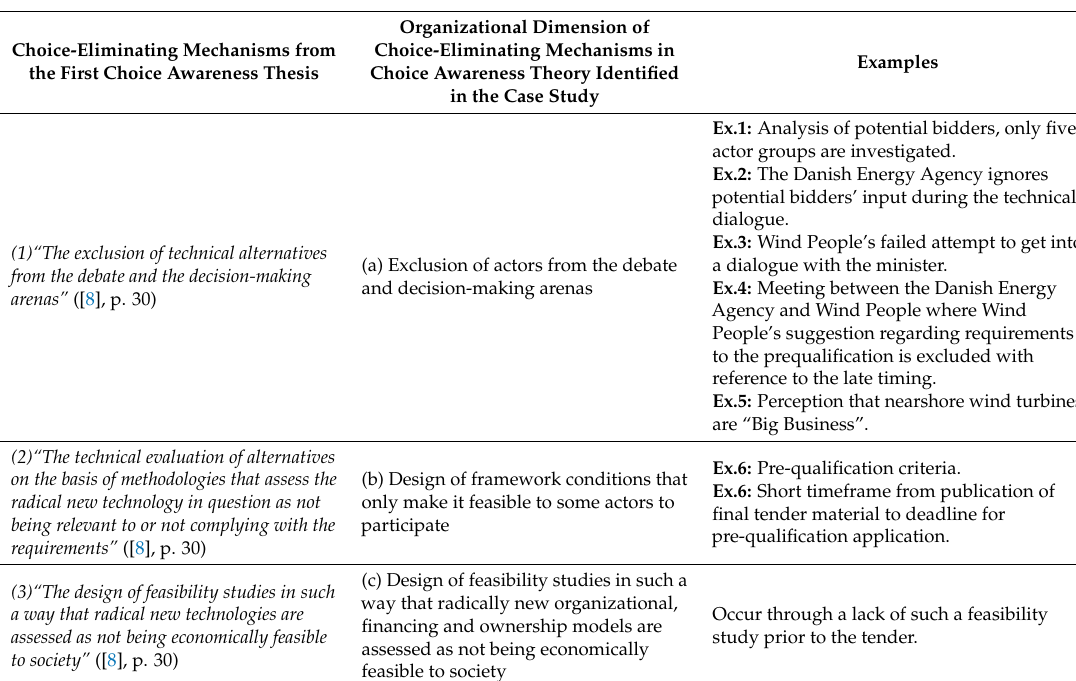
Table 1. Lund’s original Choice-Eliminating Mechanisms are presented, together with the identified organizational choice-eliminating mechanisms. The third column lists examples of these eliminating mechanisms identified in relation to the Wind & Welfare case. Each of the examples is explained further